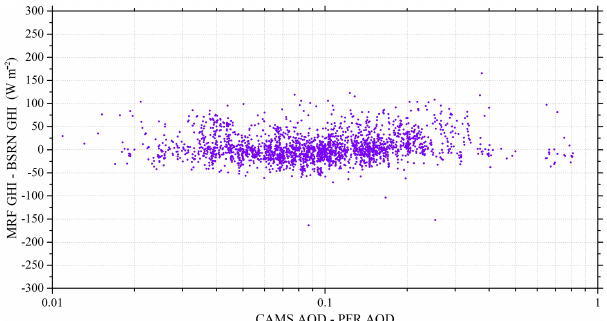
Figure 11. Absolute differences in GHI (in Wm − 2 ) derived by the MRF technique from the ground-based measurements at Izaña (BSRN pyranometer), as a function of differences in AOD from CAMS and